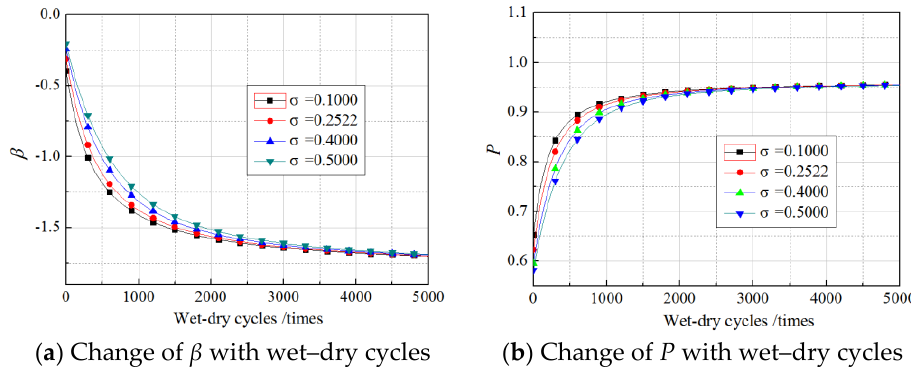
Figure 9. The effects of standard deviations of the load on the nonsustained loading specimens.